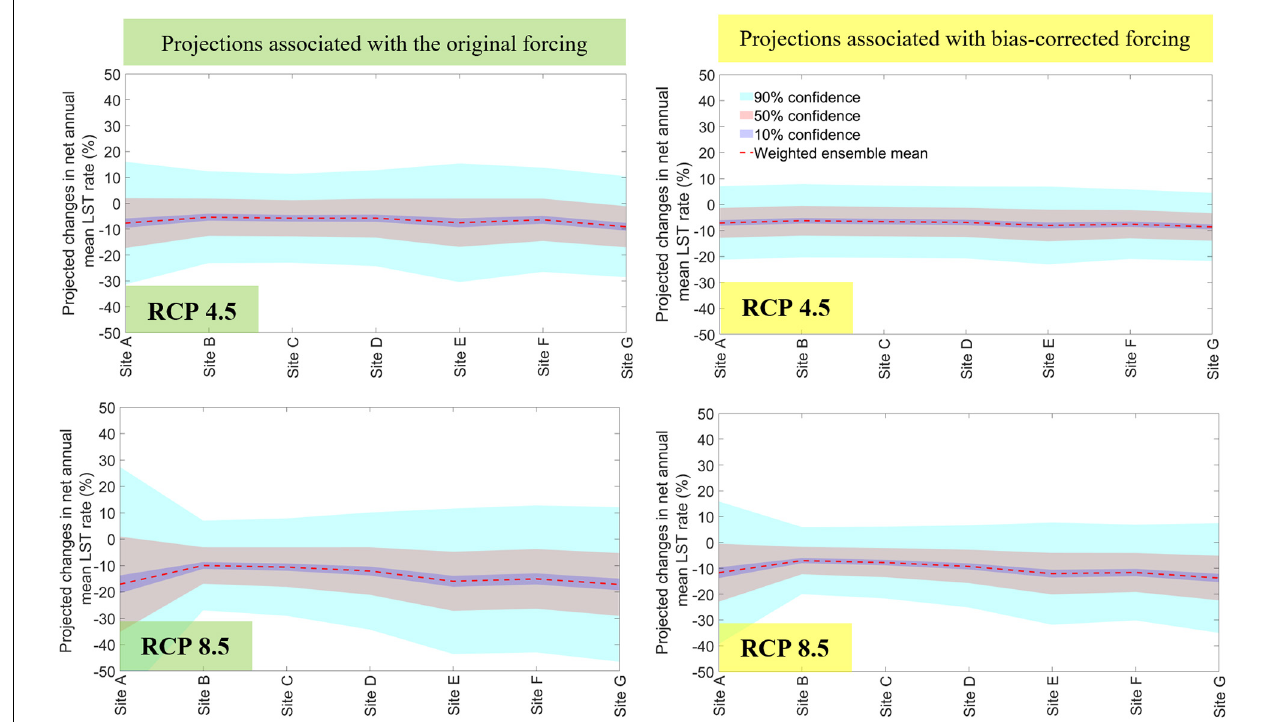
FIGURE 11 | Projected changes in net annual mean LST rate associated with the original datasets of forcing conditions (left panel) , and bias corrected ones (right panel)